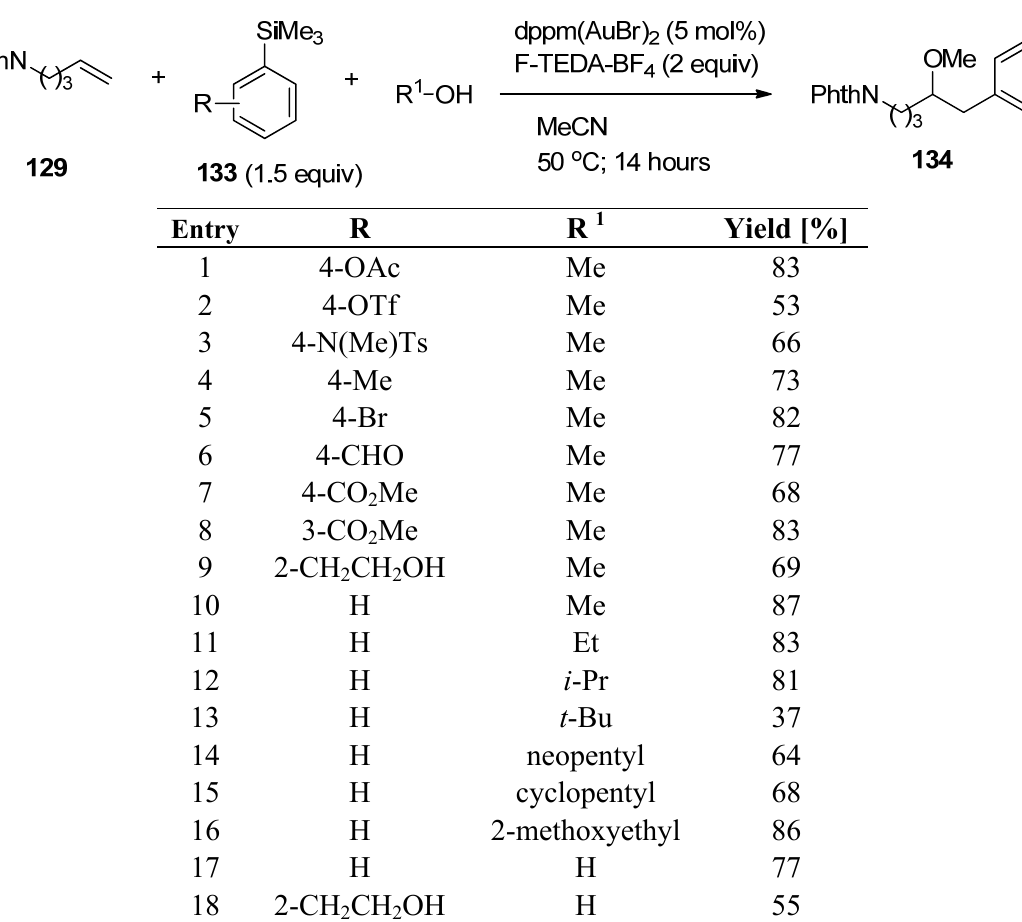
mediated three-component oxyarylation of 4